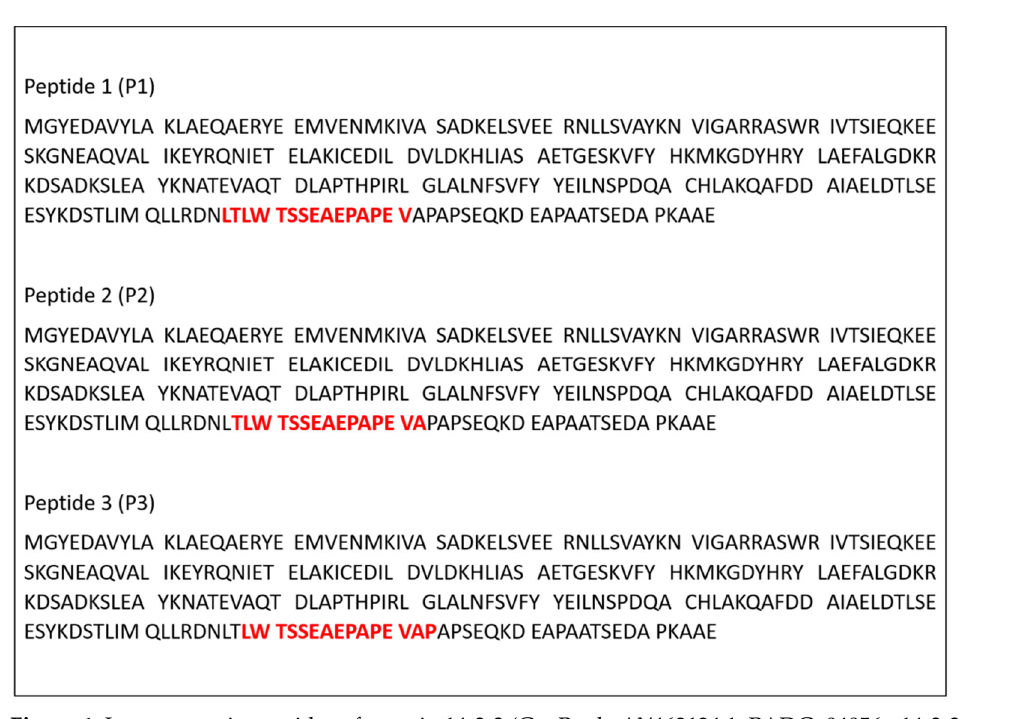
Figure 1. Immunogenic peptides of protein 14-3-3 (GenBank: AY462124.1, PADG_04056 - 14-3-3 family protein epsilon) selected by in silico analysis.